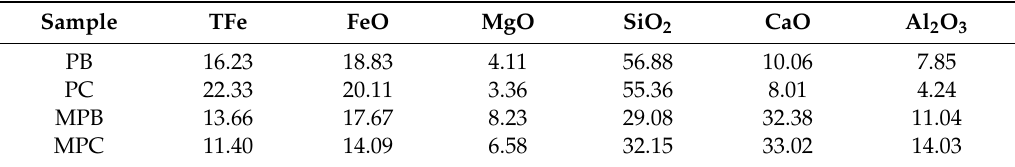
Table 4. Chemical composition of the dripping slag (wt%).